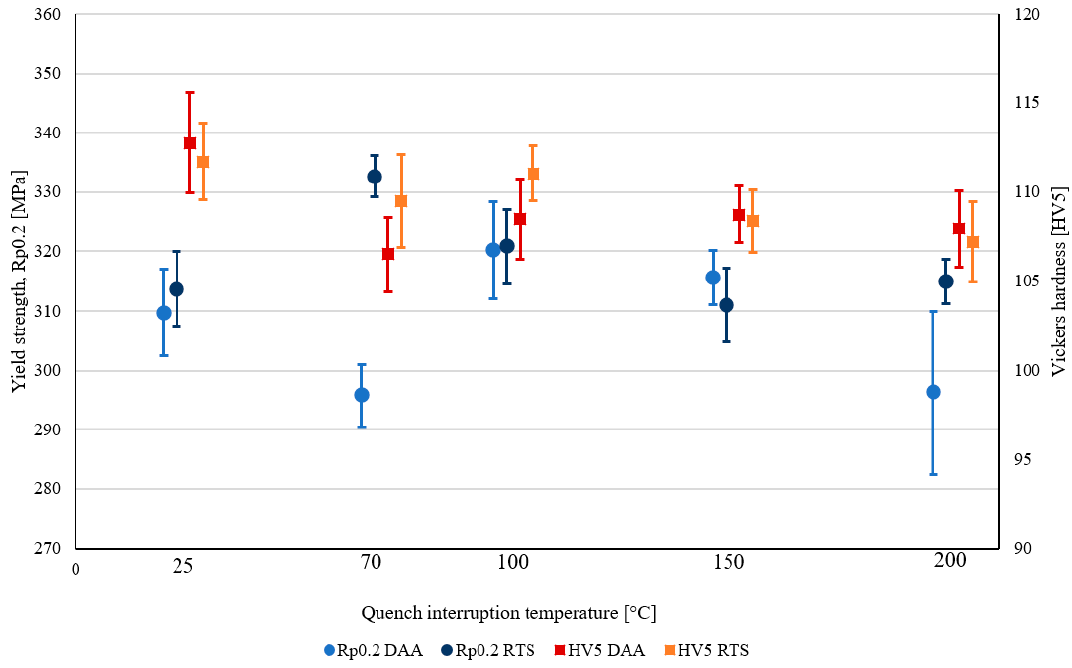
Figure 9. Average yield strength and average hardness with standard deviations for the samples being quench interrupted at quench interruption temperature before direct artificial aging (DAA) or room temperature storage (RTS).